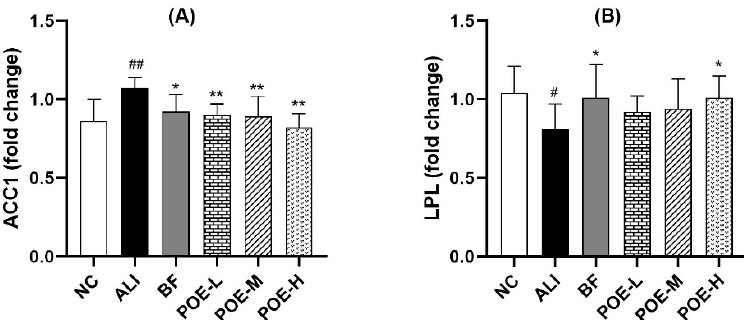
Figure 5. Effects of POE on the mRNA expression of ACC1 and LPL in liver of rats with alcoholic liver injury. (A) the mRNA expression of ACC1, (B) the mRNA expression of LPL. Values are presented as Mean ± SEM, n = 6. # p < 0.05 and ## p < 0.01 vs. NC group. * p < 0.05 and ** p < 0.01 vs. ALI group.